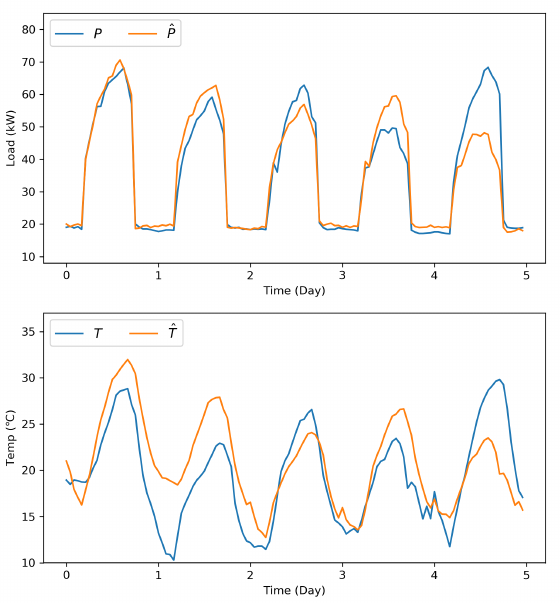
Figure 10. Temperature and load forecast using LSTM for five testing